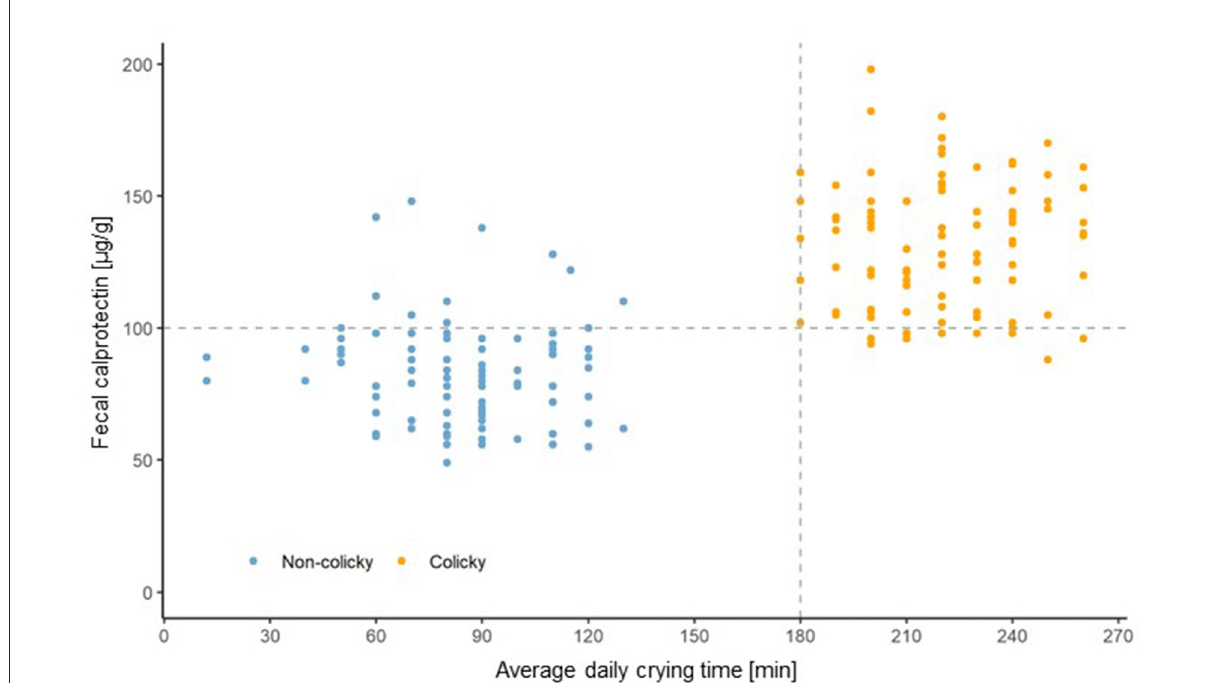
FIGURE1 Average daily crying duration plotted vs. fecal calprotectin levels in non-colicky and colicky infants.